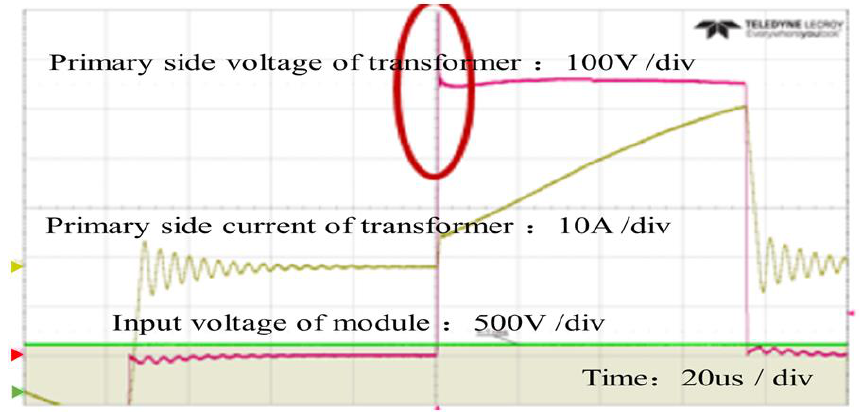
Figure 12. Voltage spike without active clamping circuit.